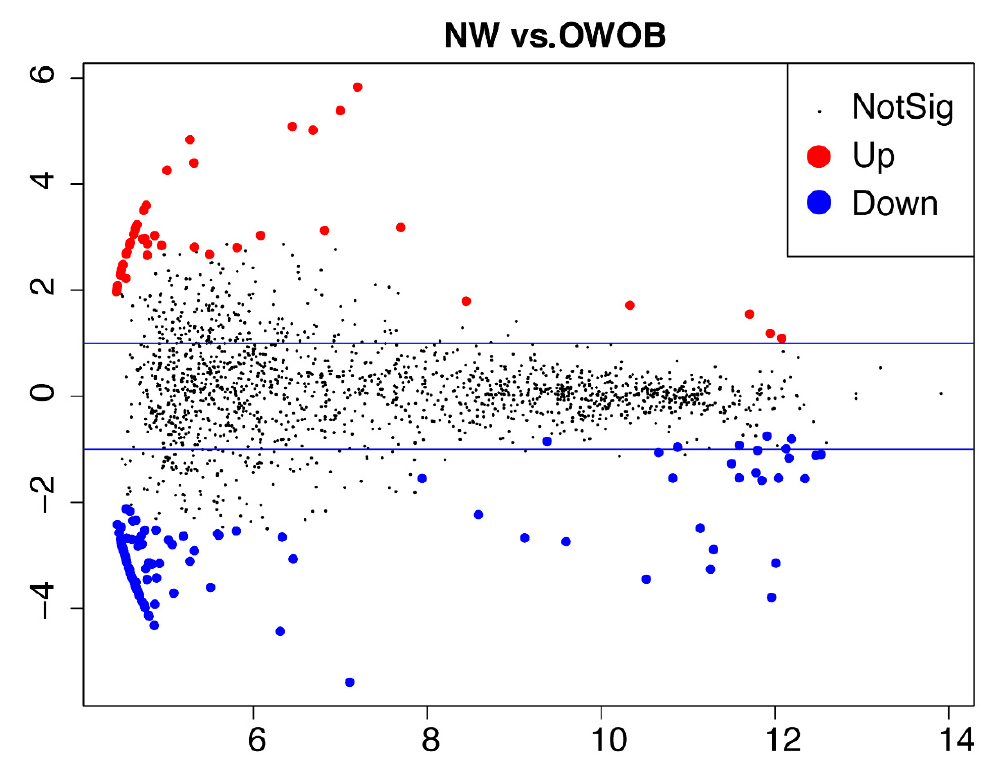
Figure 4. MA-plot showing differential microbiota genes representation (KOs) between normal- weighted vs. overweight and obese children. Differentially expressed genes (DEGs) p < 0.05; FDR adjusted p < 0.05. MA stands for the relationship between values of intensity (i.e., counts) and difference between the data (y-axis M = log ratio (log fold change) and x-axis A = mean, average of normalized counts).